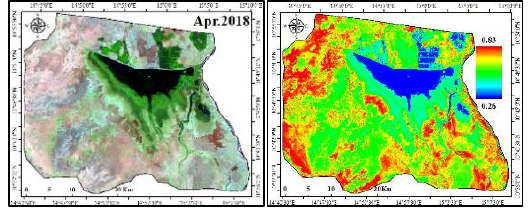
Figure 8. NDSoDI visual patterns